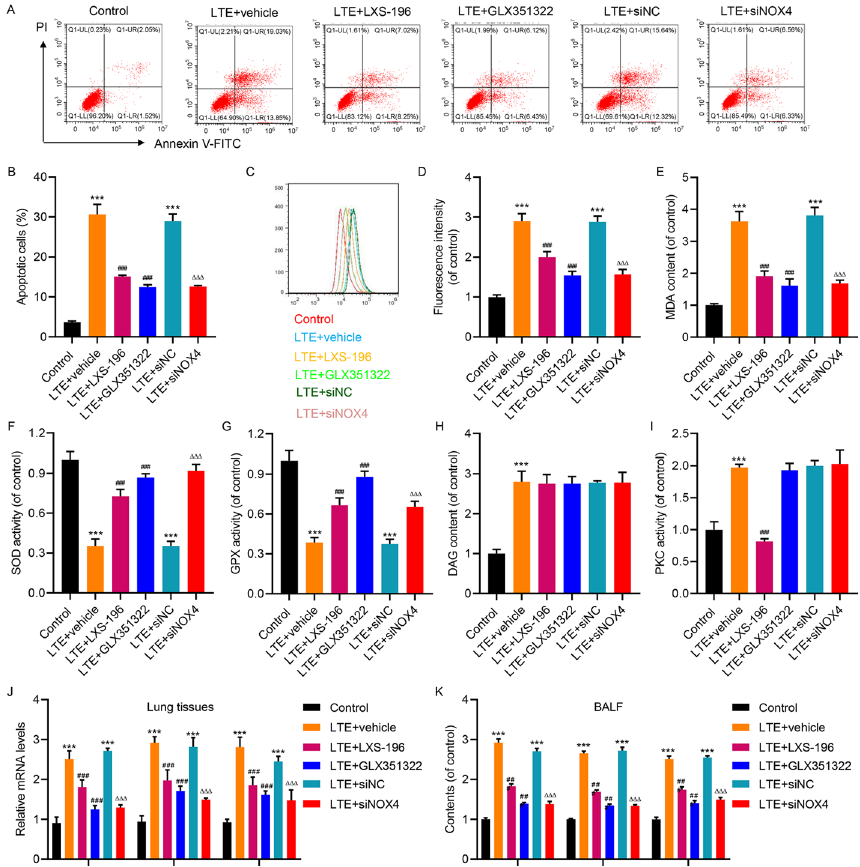
Fig. 4 Effects of T cell EVs on apoptosis, oxidative stress, and inflammation in A549 cells were attenuated by PKC/NOX4 inhibition. A549 cells were stimulated with EVs isolated from CD4 + T cells isolated from healthy subjects treated with 10 μg/mL LPS (LTE) in the absence or presence of LXS‑196, GLX351322, or NOX4 siRNA (taking siRNA to nonspecific sequence as control). A , B Flow cytometric analysis with Annexin V‑FITC/ PI double staining indicated that the elevation of cell apoptosis by LTE treatment was restored by LXS‑196, GLX351322, or NOX4 RNAi. Representative plot images from flow cytometry ( A ) and statistical analysis ( B ) are shown. C , D DCFH‑DA staining with flow cytometric analysis indicated that the elevation of ROS by LTE treatment was restored by LXS‑196, GLX351322, or NOX4 RNAi. Representative images from flow cytometry ( C ) and statistical analysis ( D ) are shown. E The elevation of MDA content by LTE treatment was restored by LXS‑196, GLX351322, or NOX4 RNAi. The reduction of SOD ( F ) and GPX activities ( G ) by LTE treatment was restored by LXS‑196, GLX351322, or NOX4 RNAi. H The elevation of DAG content by LTE treatment was not affected by LXS‑196, GLX351322, or NOX4 RNAi. I The elevation of PKC activity by LTE treatment was restored by LXS‑196, but was not affected by GLX351322 or NOX4 RNAi. The increase of ( J ) mRNA expression and ( K ) secretion of TNF‑α, IL‑1β, and IL‑6 by LTE treatment was restored by LXS‑196, GLX351322, or NOX4 RNAi. Data presented as mean SD. *** P < 0.001 versus control. ### P < 0.001 versus LTE vehicle. ΔΔΔ P < 0.001 versus ± + LTE +